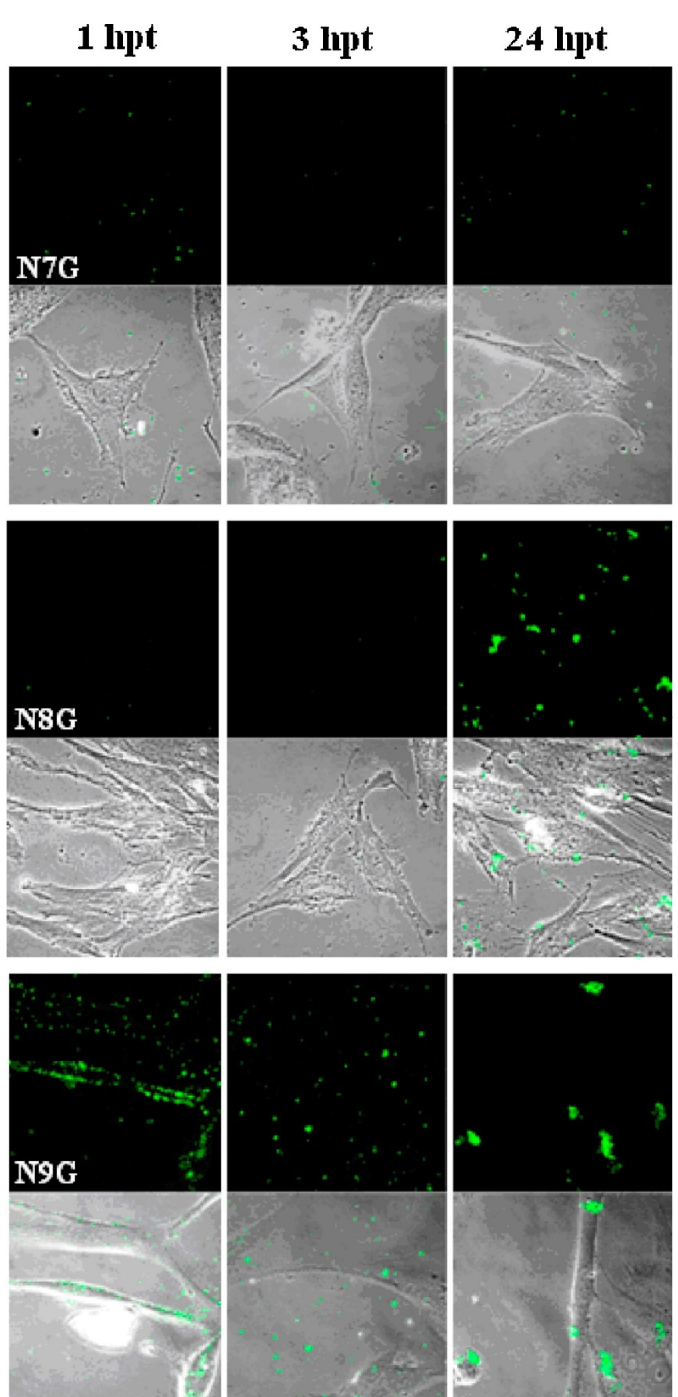
Figure 14. Evaluation of cellular uptake of fluorescent N7G, N8G, and N9G samples (CS NPs loaded with foscarnet). HELF cells (human embryonic lung fibroblasts) were incubated with the formulation for the periods indicated and then analyzed by confocal laser scanning microscopy without fixation at 1, 3, and 24 h post-treatment (hpt). The upper panels show fluorescent images while the lower panels show fluorescent images merged with phase-contrast images [256]. Reproduced with permission from Elsevier (Copyright©2014).